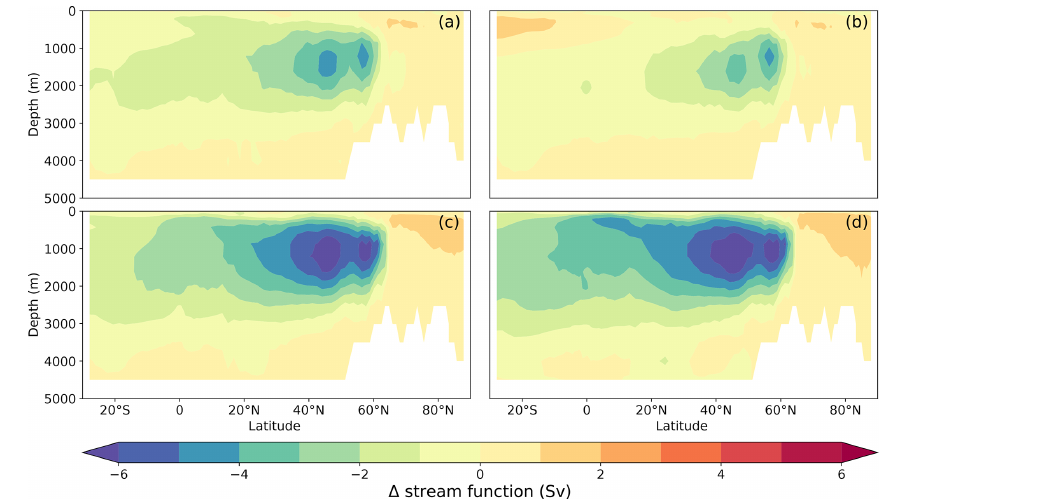
Figure 2. Stream function difference between future scenarios (2041–2070) and historical simulation (1976–2005). The future scenarios are (a) RCP8.5, (b) WAIS3m, (c) GrIS1m and (d) GrIS3m.